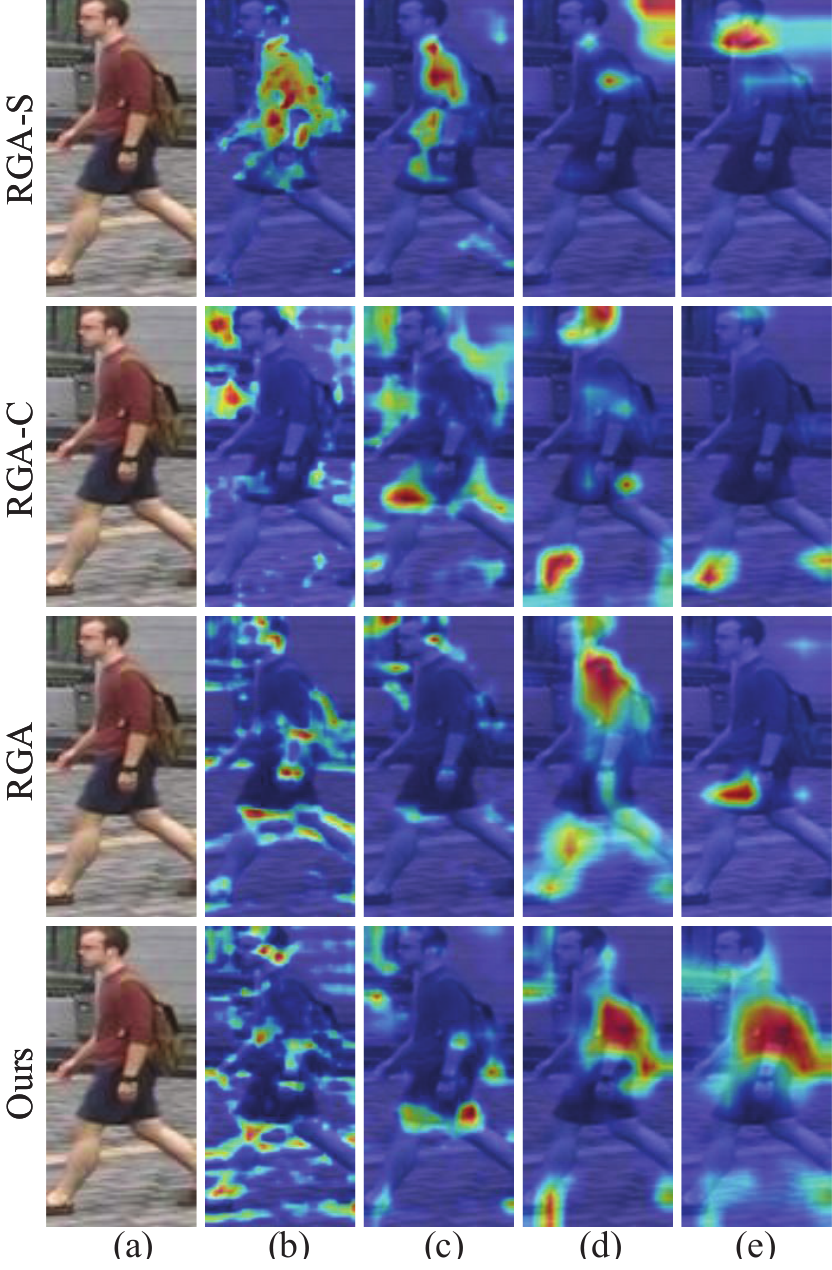
Figure 9. Grad-CAM visualization for attention modules from different blocks: ( a – e ) correspond to the original image and the outputs from the attention module after block1, block2, block3, block4 of ResNet-50. For our model, ( a , b ) represent the outputs from block1 and block2,